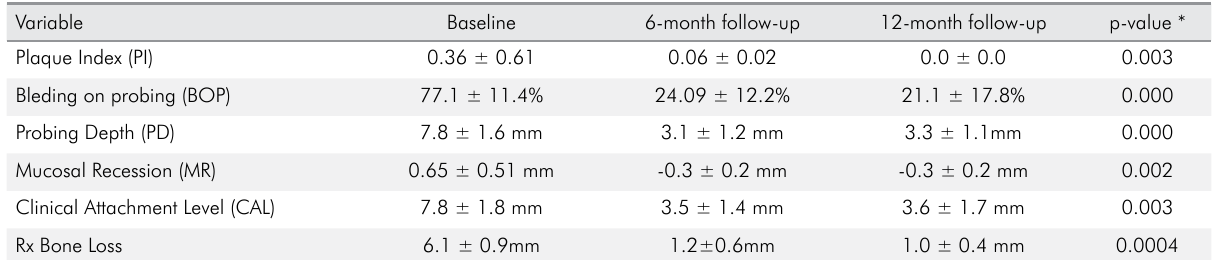
Table. Clinical parameters (mean±SD) at baseline and 6 months and 12 months (13